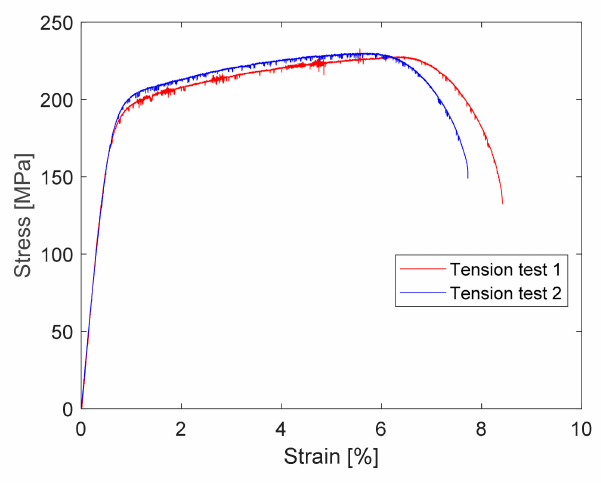
Figure 3. AA6060-T6 material stress–strain curve from tension tests. Table 1. AA6060-T6 material properties.